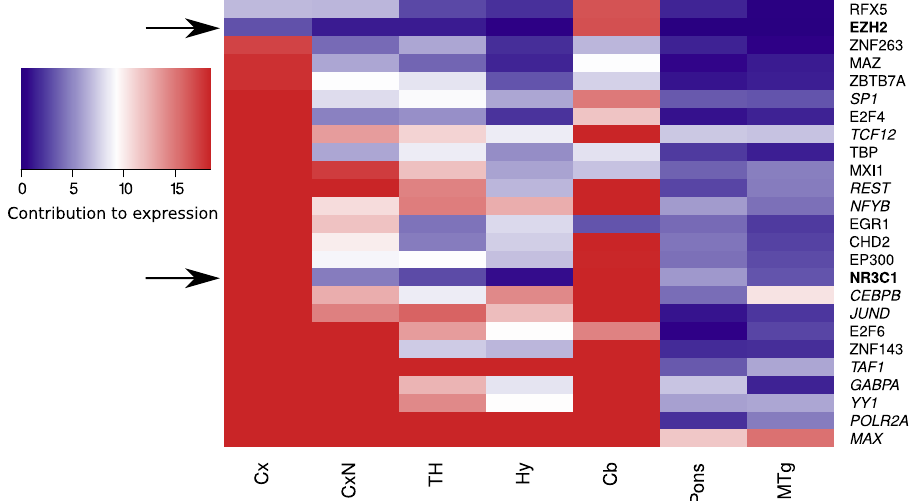
Figure 1. Transcription factor contributions to gene expression. The color gradient indicates the contribution to gene expression and is capped between 5% and 95% quantiles for all transcription factors (rows) in all depicted region (columns). Cx refers cerebral cortex, CxN to cerebral nuclei, TH to thalamus, Hy to hypothalamus, Cb to cerebellum and MTg to mid-brain tegmentum. Depicted are the contributions of the 25 transcription factors with the strongest contribution in any of the regions at depth 3 from one instance out of a five-times repeated analysis. Arrows point to transcription factors with localized contributions (bold font). Italic font indicates transcription factor with comparably strong contributions to gene expression in all regions and all instances of the analysis including different region hierarchy depths.